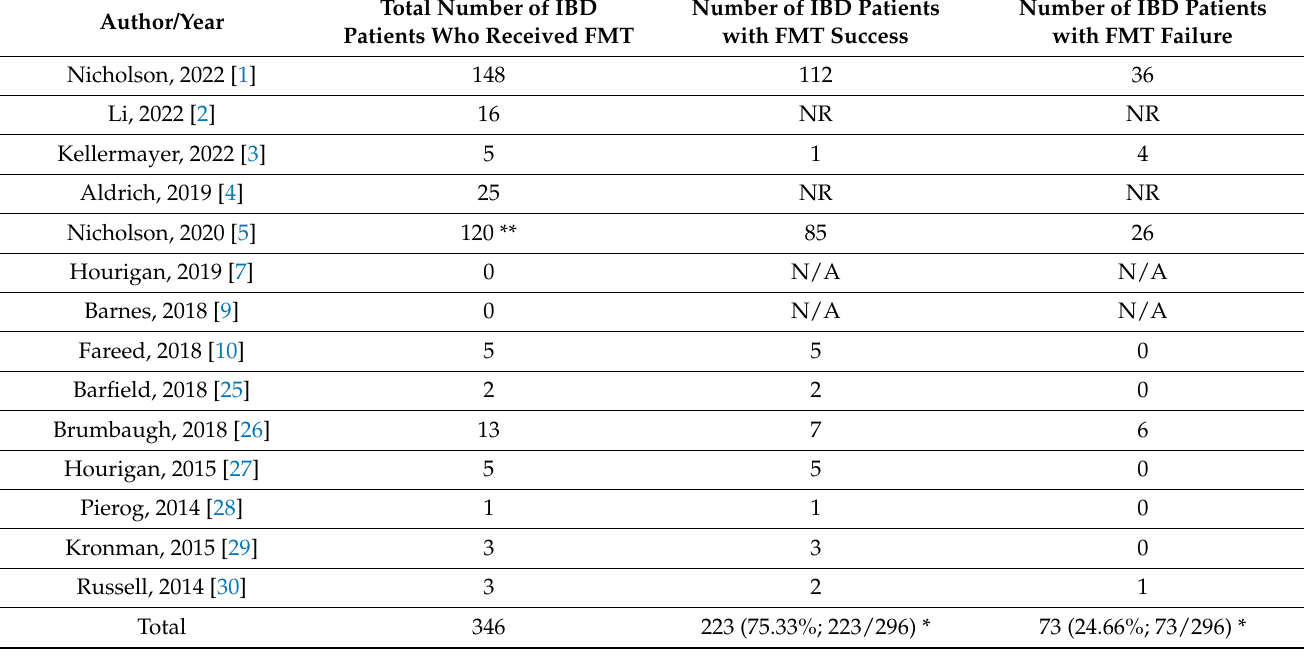
Table 6. Efficacy outcomes by IBD.